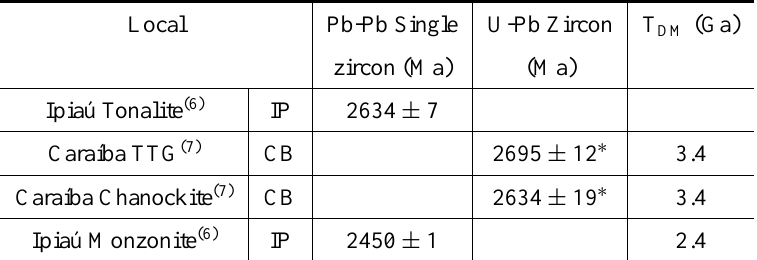
Itabuna-Salvador-Curaçá Belt. Ages of the Archean main plutonic rocks according to different radiometric methods. Ledru et al. (1993) (6), Silva et al. (1997) (7). Asterisks represent SHRIMP data. WR = Whole Rock.